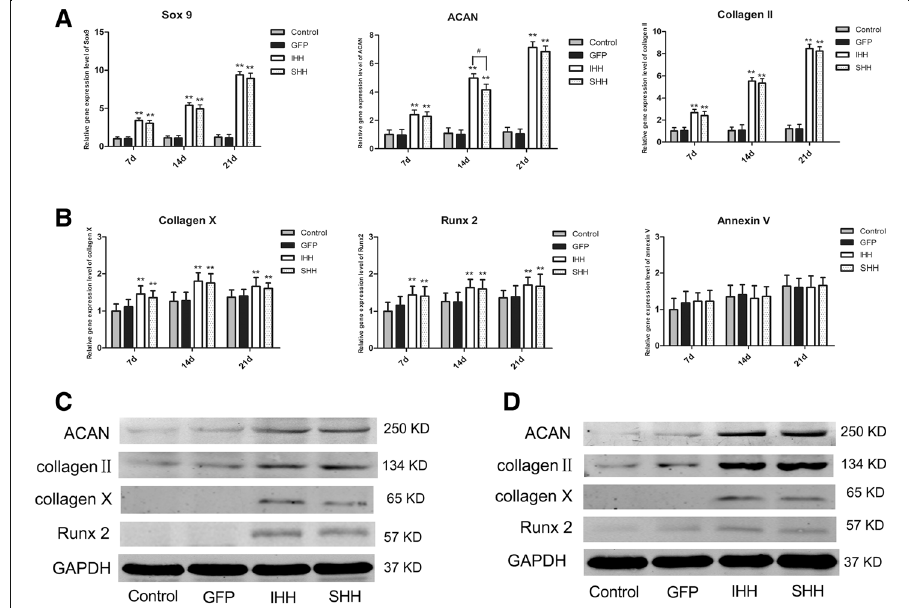
Fig. 4 Expression levels of related genes during differentiation induction in the RCCS environment. ( a ) qPCR analysis of Sox9, ACAN and collagen II on days 7, 14 and 21 during induction. ( b ) qRT-PCR analysis of collagen X, Runx2, and annexin V on days 7, 14 and 21 during induction. The results were normalized to B2M mRNA expression. Values are means ± SD ( n = 3). ( c ) Expression of ACAN, collagen II, collagen X and Runx2 was detected by western blotting on day 10 during differentiation induction. ( d ) Expression of ACAN, collagen II, collagen X and Runx2 was detected by western blotting on day 21 during differentiation induction. Significant differences from the control group (non-transfection cells) are indicated by * p <0.05 or ** p <0.01; differences between IHH and SHH transfection groups are indicated by # p <0.05 or ## p